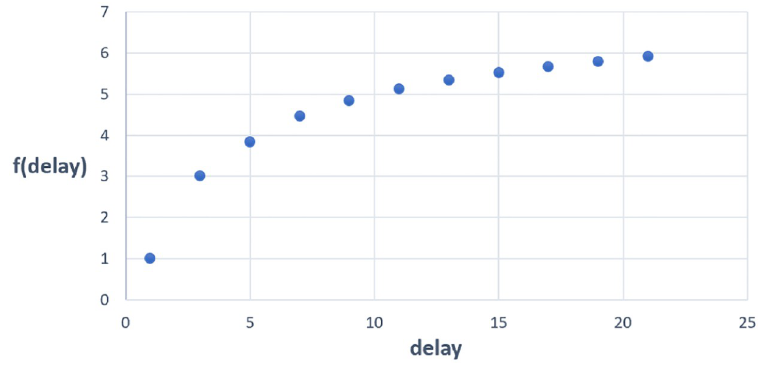
Fig 3. Visualization of delay